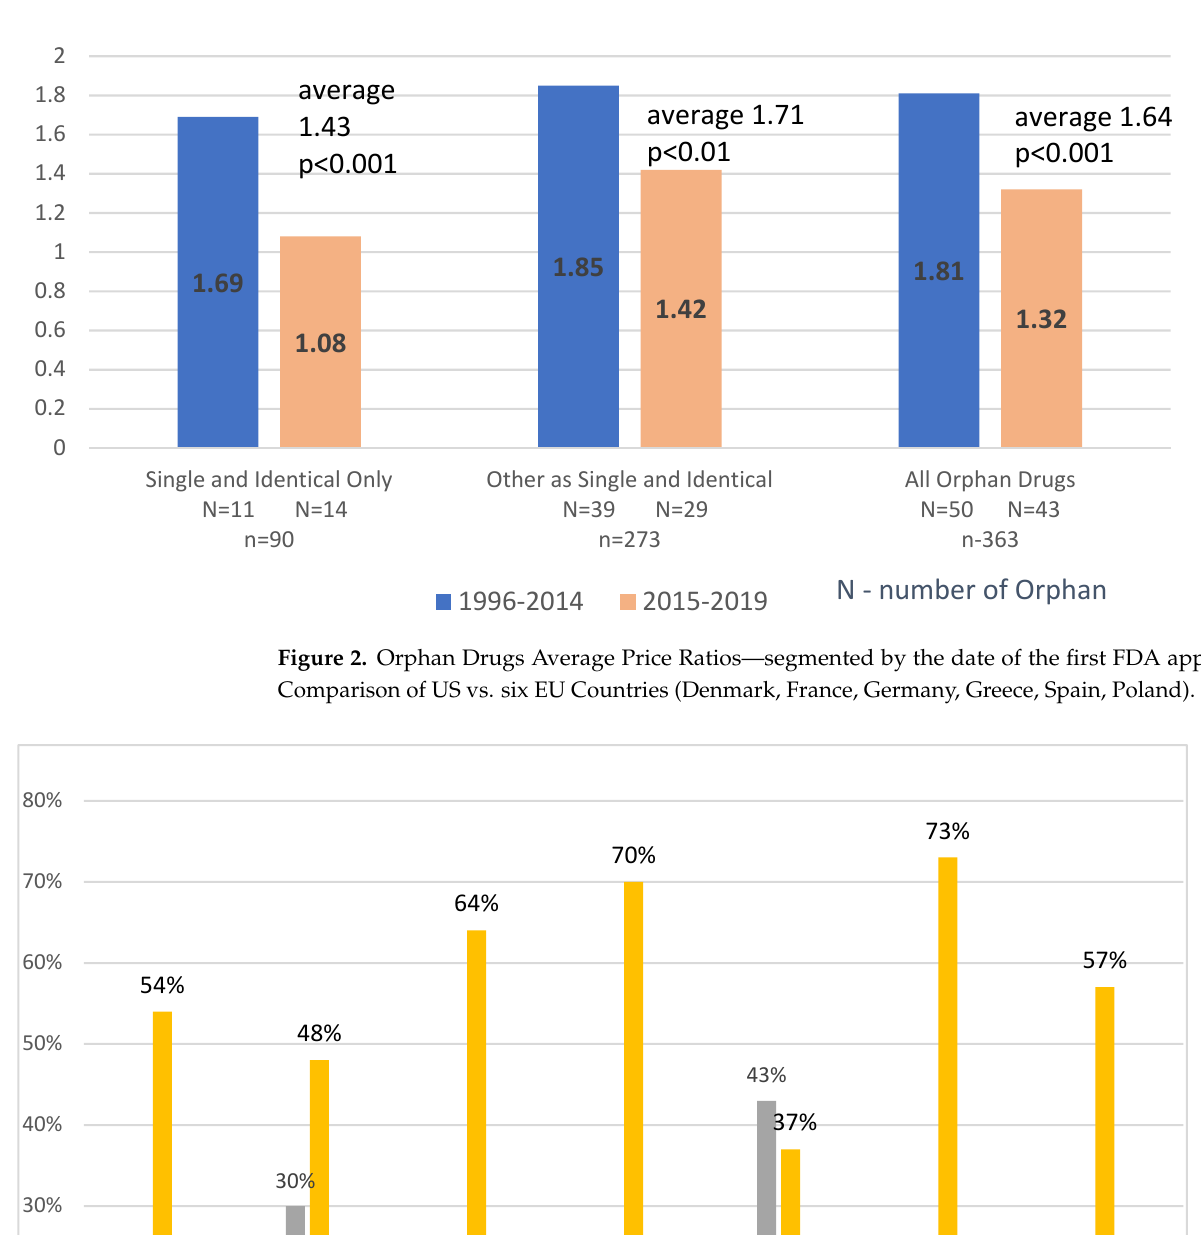
11 of 18 Figure 1. Distribution of VAFFS/EU Price Ratios per Country. Average Price Ratios calculated for Orphan Drugs registered in the years 1996–2014 were significantly higher compared to Price Ratios from the years 2015–2019 in all